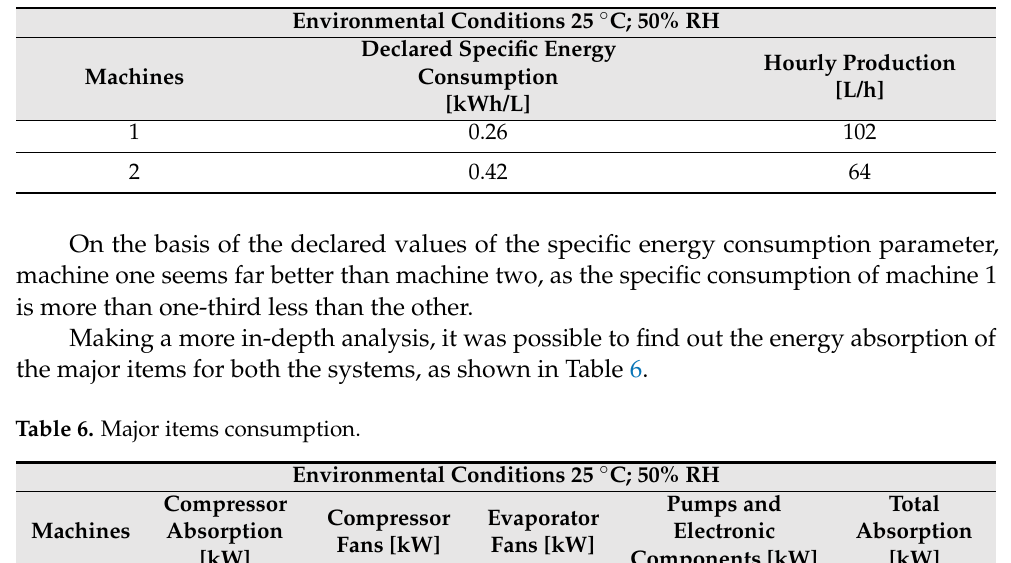
Table 5. Manufacturer declared data for the two AWG machines.